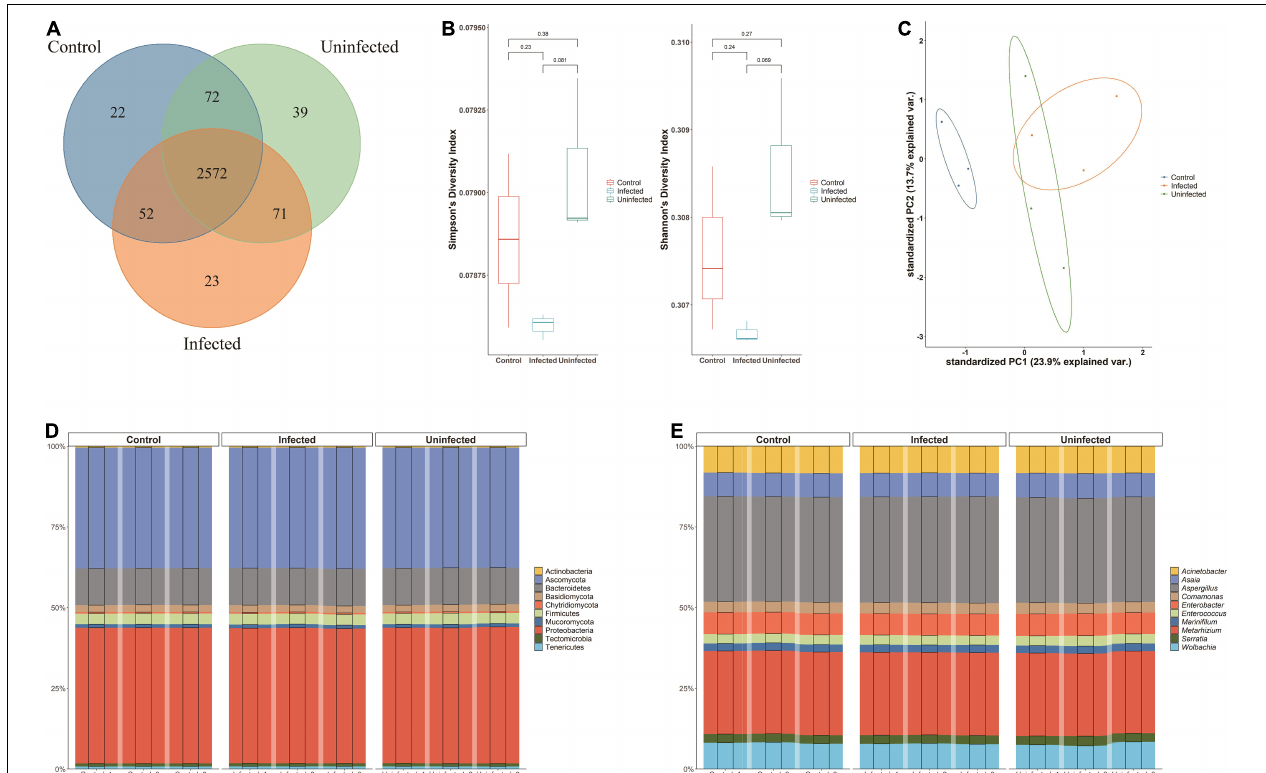
FIGURE 1 | Microbiota of Aedes albopictus . (A) Venn diagram of the overlapped species among DENV2-infected, DENV2-uninfected, and control group. (B) Within-sample diversity (alpha-diversity) with Shannon and Simpson index among three groups. The horizontal bars within boxes represent medians. The tops and bottoms of boxes represent the 75th and 25th percentiles, respectively. The upper and lower whiskers extend to data no more than 1.5 × the interquartile range from the upper edge and lower edge of the box, respectively. (C) Unconstrained principle component analysis (for principal coordinates PC1 and PC2) with Bray–Curtis distance. (D) The microbiota composition of the three groups at the phylum level. (E) The microbiota composition of the three groups at the genera level.